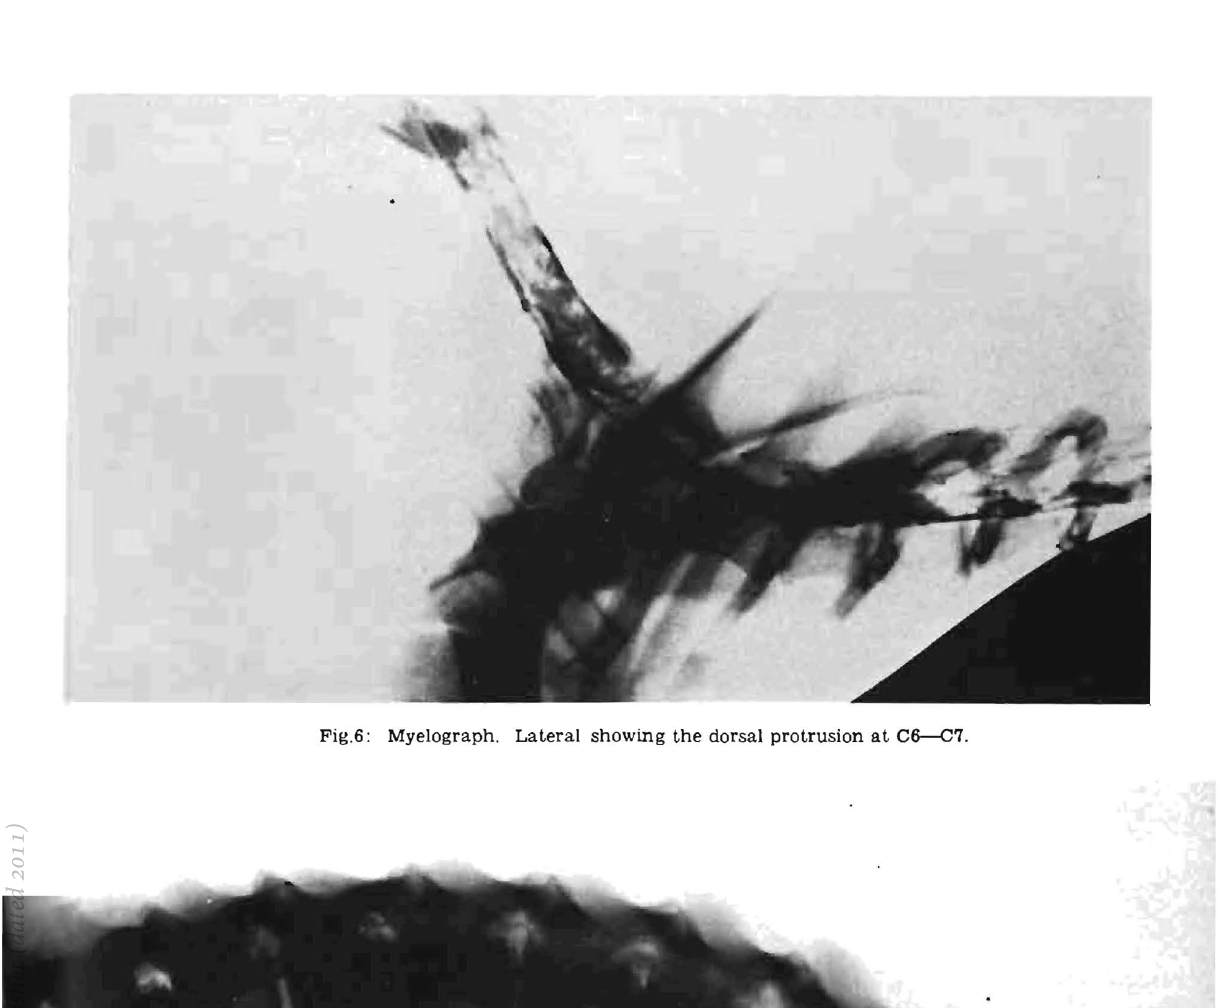
Fig.6: Myelograph. Lateral showing the dorsal protrusion at C6--C7.